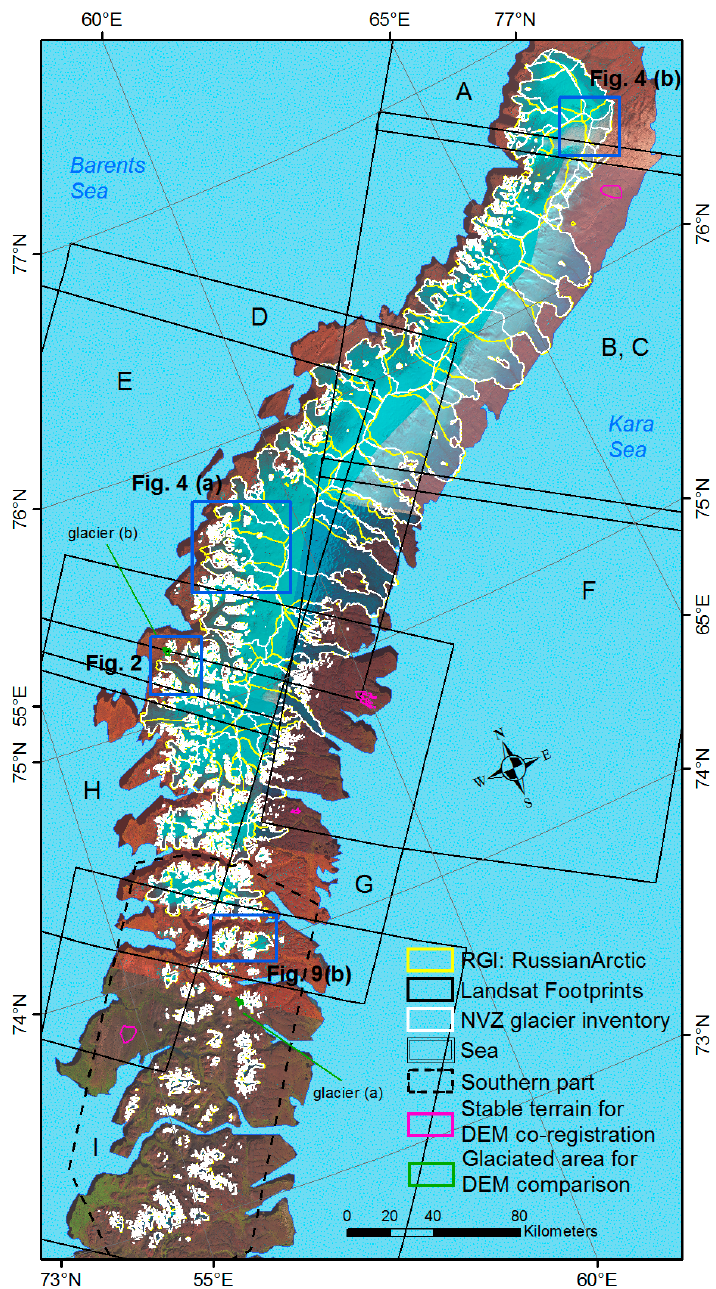
Figure 1. The islands of Novaya Zemlya, with outlines from the new NVZ glacier inventory and the RGI 5.0. Landsat footprints are shown in black and stable terrain for DEM co-registration is in pink.